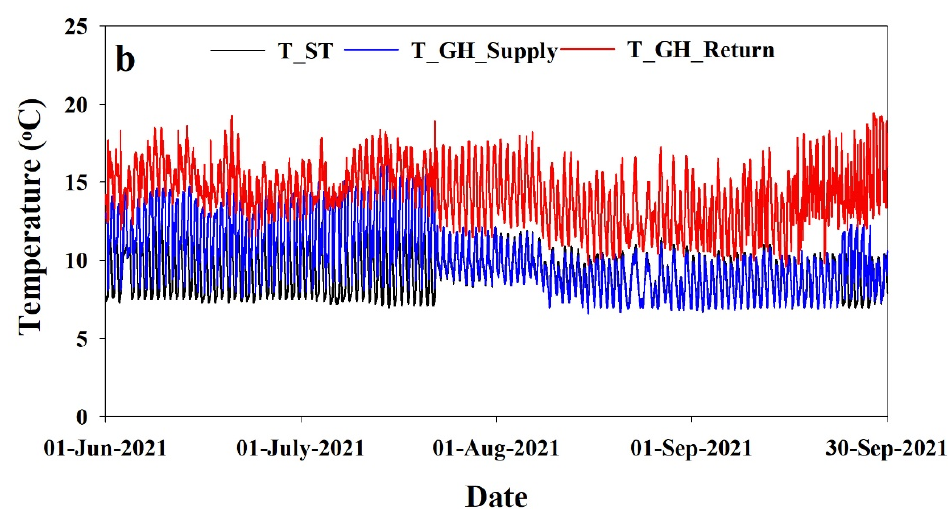
Figure 6. Storage tank and greenhouse supply and return water temperature in ( a ) winter and ( b ) summer.